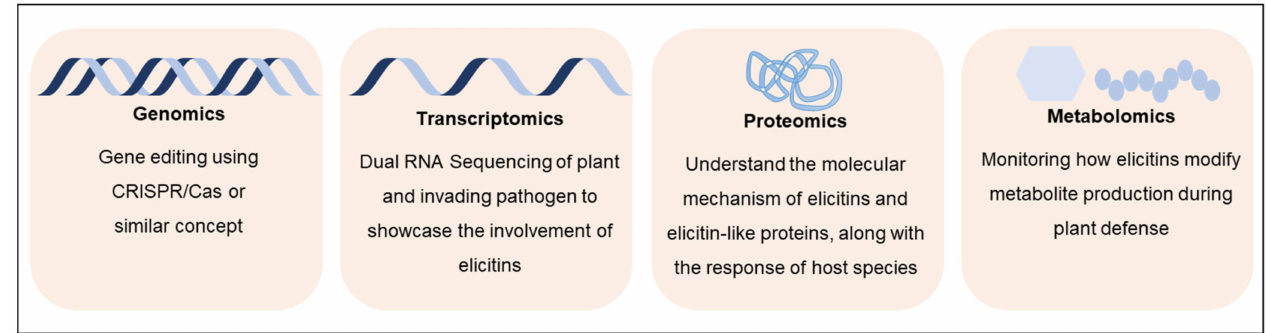
Figure 4. The four omics platforms that can be adapted to solve the underlying uncertainties around elicitin functions and to further understand their involvement in plant–pathogen